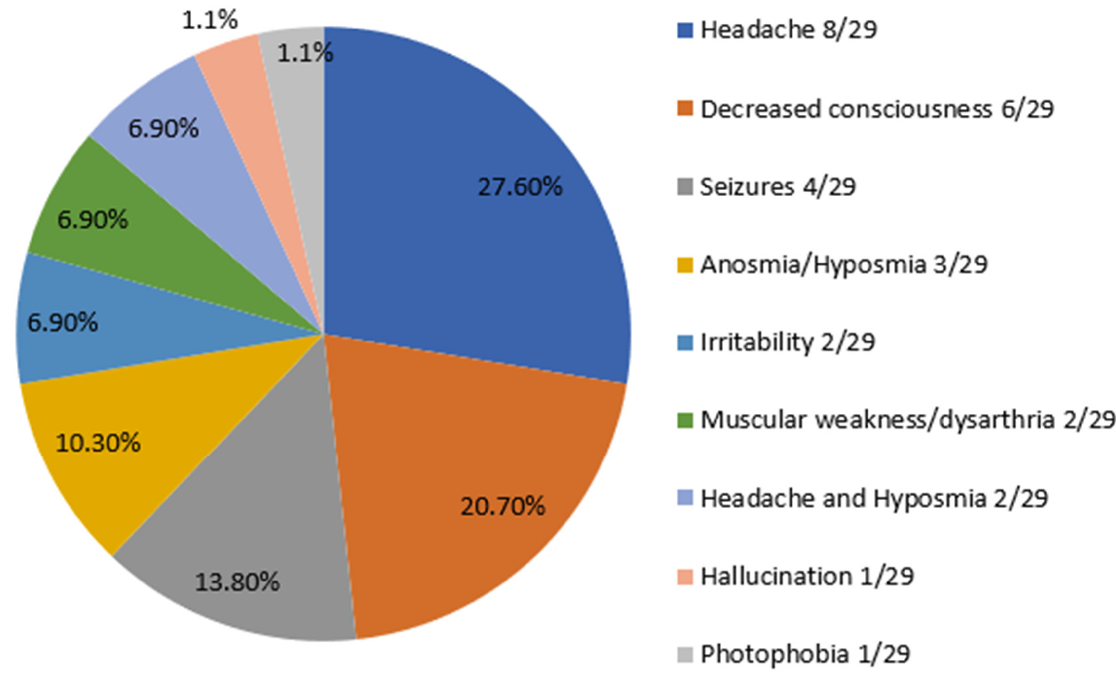
Figure 1. Frequency distribution of neurological symptoms in 29 pediatric COVID-19 patients with neurologic involvement.